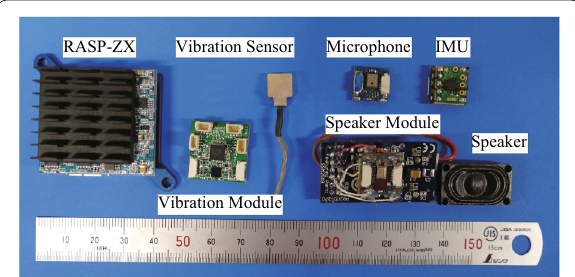
Fig. 3 Photo of RASP-ZX, IMU, microphone, speaker, vibration sensor